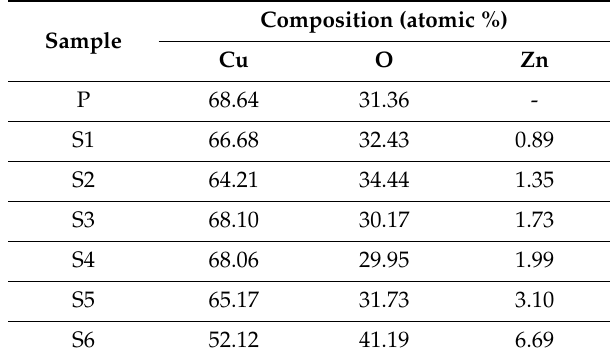
Table 1. Elemental composition of pure and Zn-doped CuO films. Composition (atomic Sample